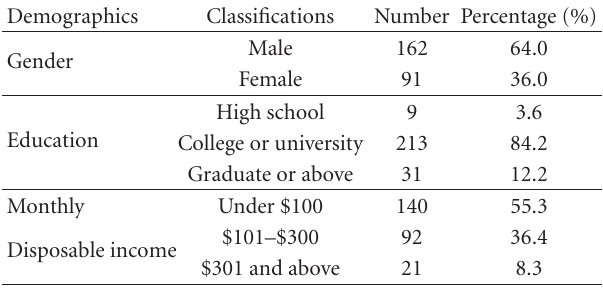
Table 3: Sample description.